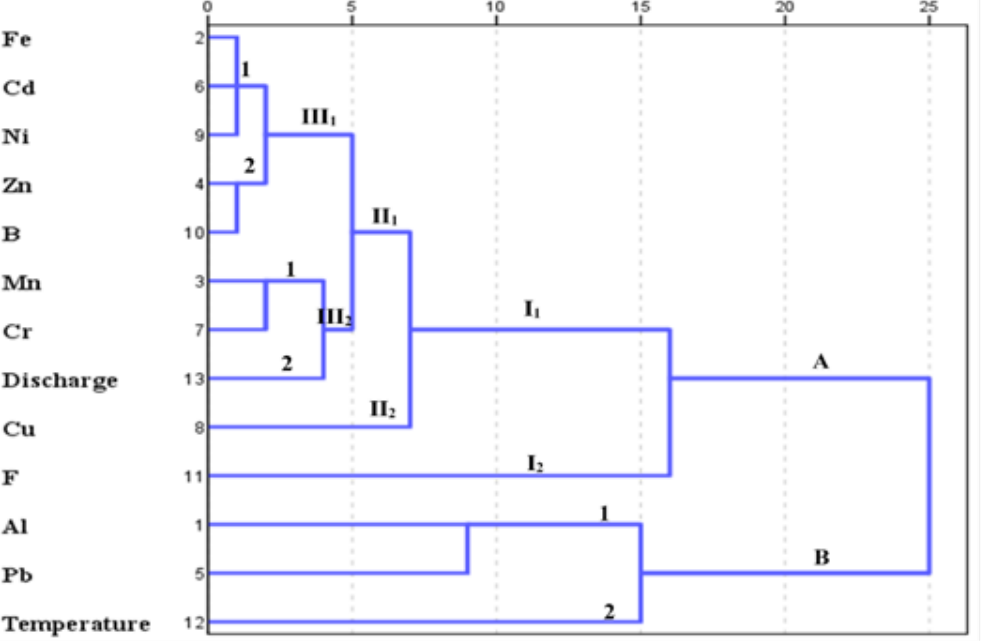
Fig. 5 The cluster diagram of Silakhor River water